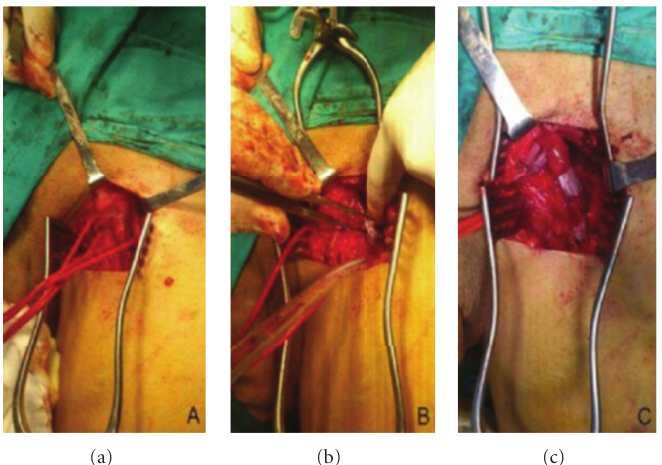
Figure 1: (a) Exploration of saphenofemoral venous junction. (b) Veins were turned, and Venocu ff was placed around. (c) The view of the veins after the Venocu ff